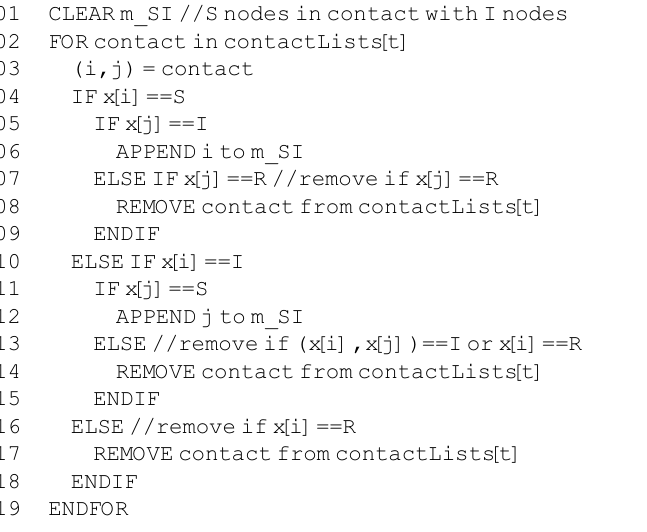
S1 Fig. Numerical results from temporal Gillespie and rejection sampling algorithms for contagion processes taking place on empirical networks. (A) – (D) for a SIR process and (E) –